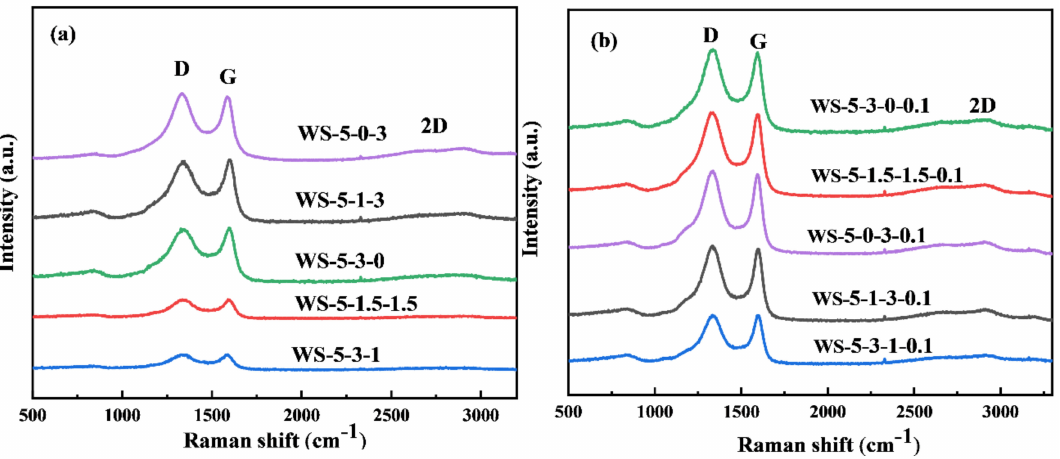
Figure 4. The Raman spectra of biochar prepared by ( a ) different ratios of metal salts and ( b ) different ratios of metal salts and 0.1 mL min − 1 H 2 O(g) activation.